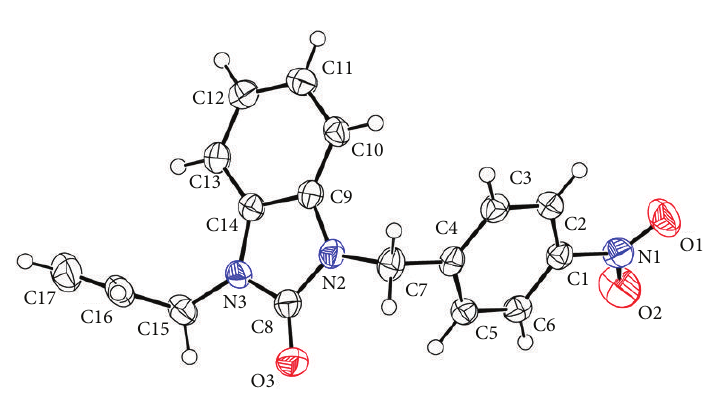
Figure 1: ORTEP representation of 5 (displacement ellipsoids are drawn at the 50% probability level).